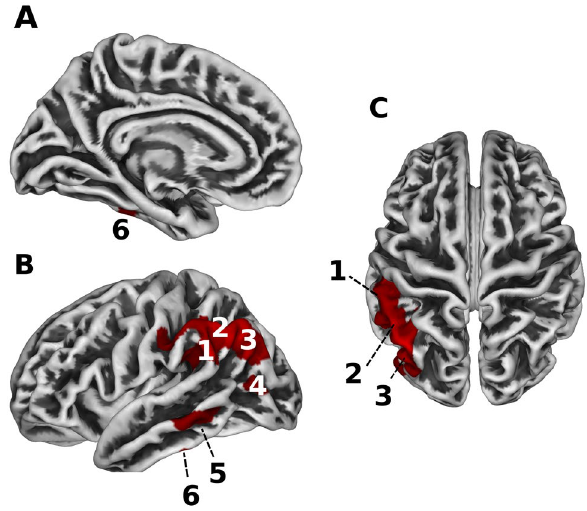
Figure 5. Reduction in cortical surface thickness in the hearing loss group without tinnitus compared to the control group. The three panels show a medial (A) and lateral (B) view of the left hemisphere, and a top view (C) of the entire brain. Areas that contained less cortical surface thickness in the hearing loss group without tinnitus compared to the control group (FWE < 0.05, TFCE) are shown in red. These areas include the supramarginal gyrus (1), the angular gyrus (2), the inferior parietal lobule (3), lateral occipital area (4), and the middle temporal (5) and inferior temporal areas (6), all on the left side of the